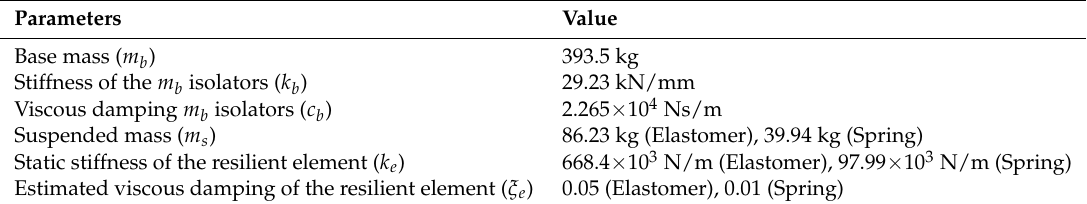
Figure 2. Experimental setup for the elastomeric element ( a ) and for the coil spring element ( b ). Table 1. Mechanical parameters of the experimental